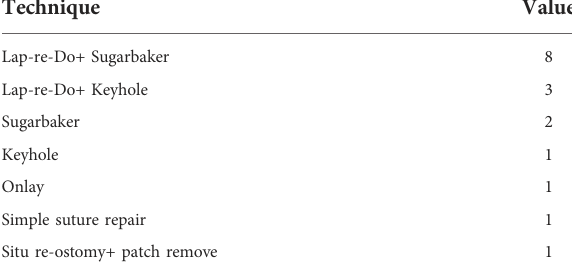
TABLE 3 Statistics of the number of surgical cases.